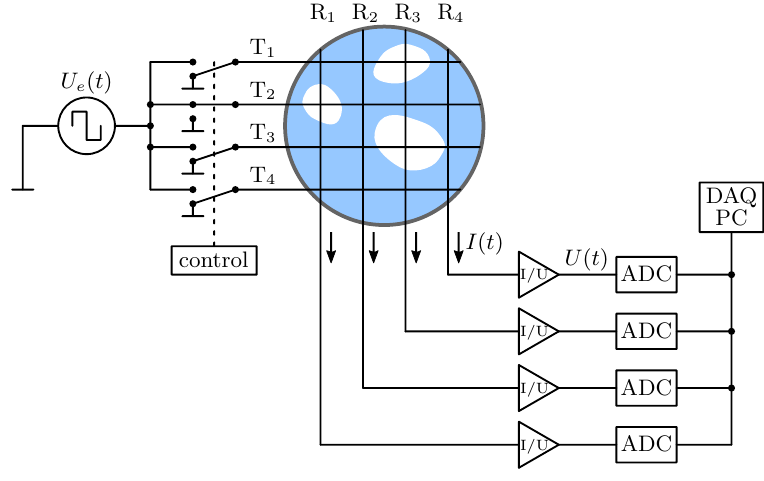
Figure 1. Schematic representation of the wire-mesh sensor. Adapted from